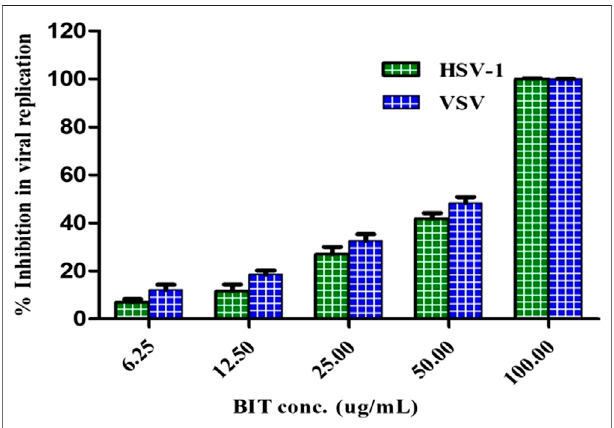
FIGURE 3 | Effect of BIT different concentrations on HSV-1 and VSV growth using direct plaque reduction